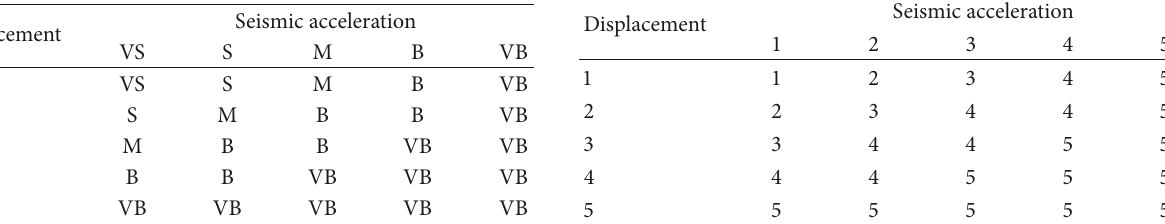
Table 2: Fuzzy control rule table (current).